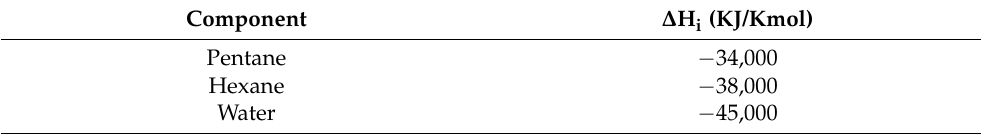
Table 3. Heat of adsorption for three